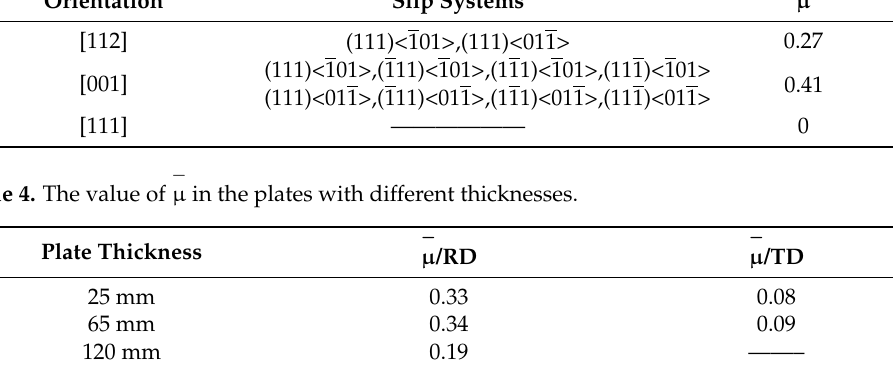
Table 3. The orientations, slip systems and the value of µ .